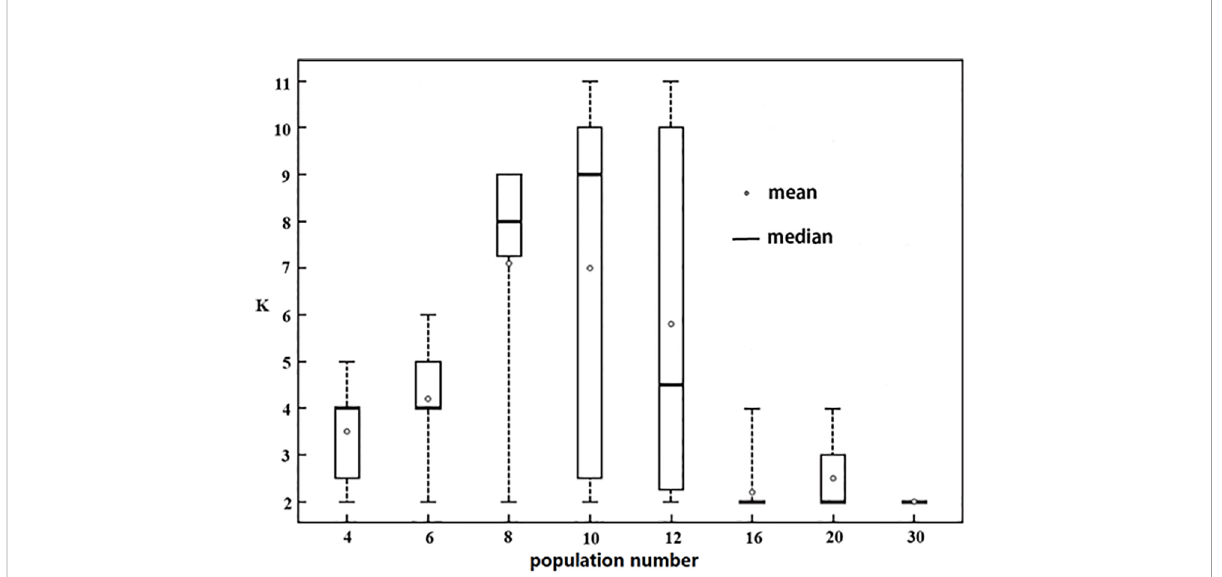
FIGURE 5 Change of optimal K values with the increase of sampling population number. The number on the horizontal axis is the number of populations randomly selected from 38 populations, the vertical axis indicates optimal K value obtained in STRUCTURE analysis. At every level of population number, 10 random samples were conducted without repetitive populations in every sample, and the range, the maximum, the minimum, the mean value, and the median of optimal K were shown.